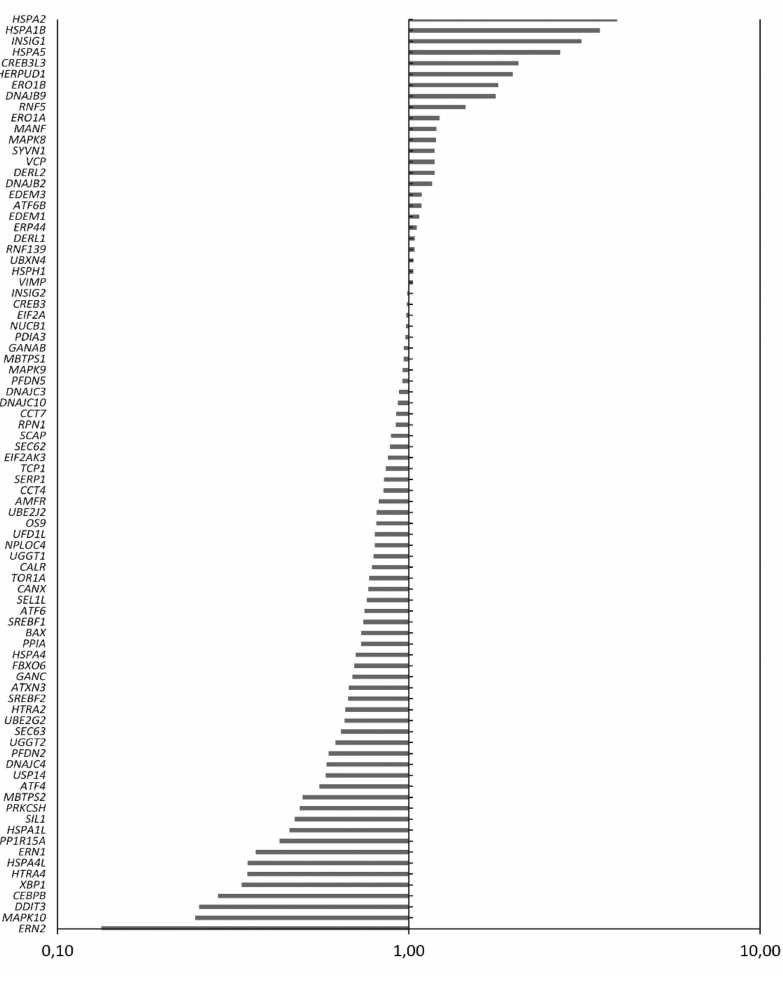
Figure 5. Q-PCR assay of 84 UPR-related genes following exposure of the H929 cell line to 10 µ M GSK2606414 for 24 h and further subjected to Tunicamycin-induced endoplasmic reticulum (ER) stress for another 24 h. Results for GSK2606414-treated vs. untreated cells are shown. 2.6. GSK2606414 Exerts Synergistic to BTZ E ff ects in MM